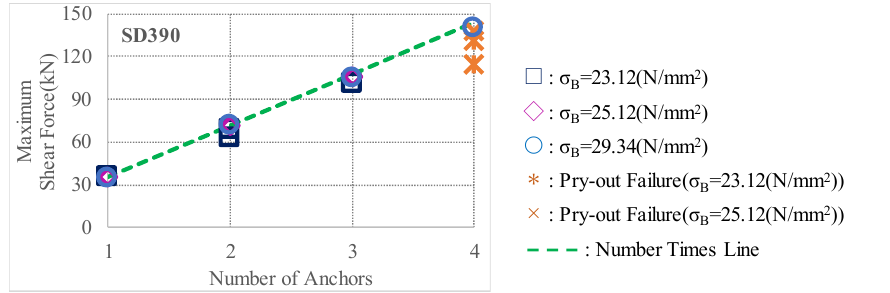
Figure 6. Maximum shear force - number of anchors relations. (SD390).